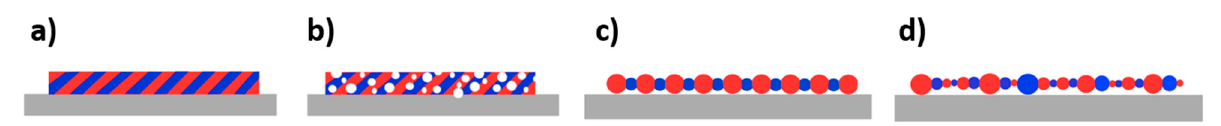
Figure 6. One-dimensional diagrams of the “effective” material structure given by: ( a ) bulk material with combined thermal properties, ( b ) bulk material with voids filling space to %TMD, ( c ) single 1D chain of identical alternating fuel and oxide particles, and ( d ) a single one-dimensional chain of various sized alternating fuel and oxide particles.